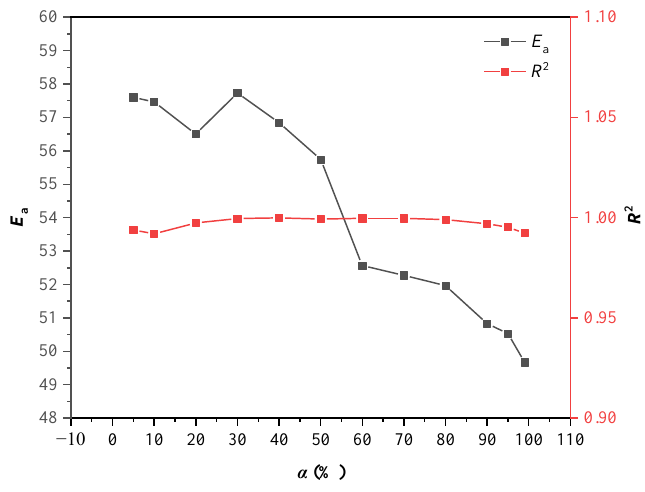
Figure 8. E a plots of Kissinger model at different β in DSC experiments for LP30 + PFPN.